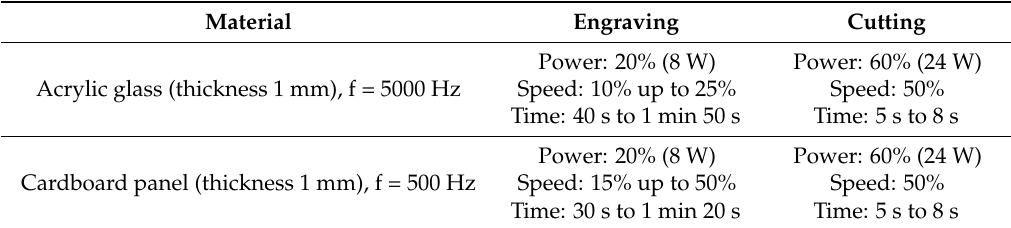
Table 1. Device parameters for fabrication of capacitive markers, the power and speed of the laser can only be controlled in relative percentages. In order to be able to reproduce and assess the results, the device parameters and the processing times are